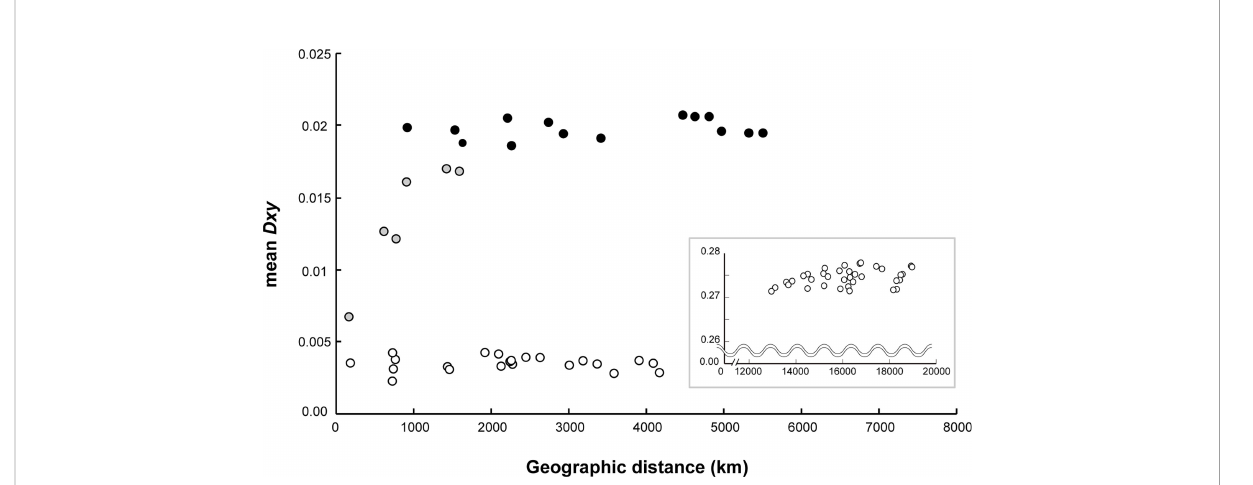
FIGURE 4 Correlation of average population divergence ( D xy ) with geographic distance between the CIR and the eastern Paci fi c. The gray circles represent the comparison between vent fi elds within the CIR, and the white circles represent the comparison between vent fi elds within each region of the eastern Paci fi c, the EPR with the GAR, and the PAR. The black circles represent the comparison between the EPR and the PAR in the eastern Paci fi c. The graph in inset illustrates the comparison between the CIR and the eastern Paci fi c. This analysis included data collected for 30 years from 1990 at the GAR on the East Paci fi c Ocean to 2018 at the Onnuri vent fi eld on the Indian